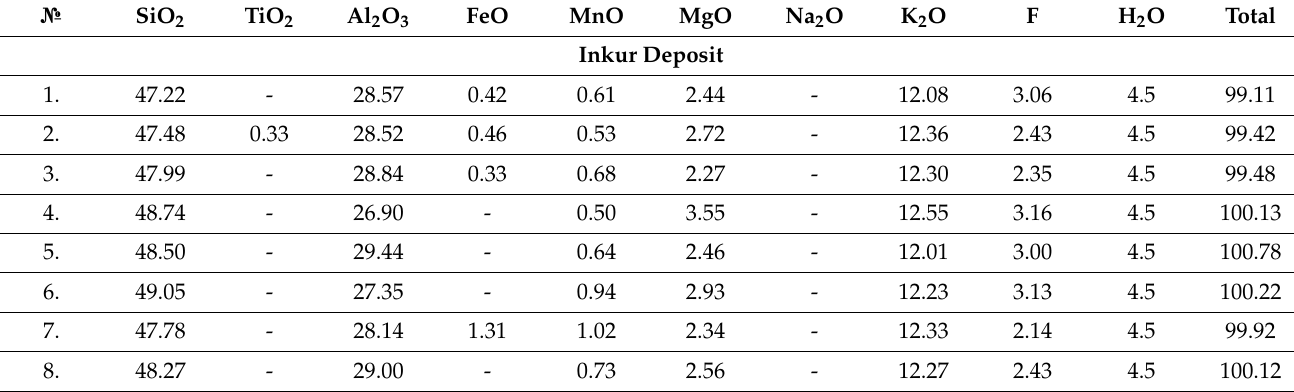
Table 2. Chemical composition of muscovite from Inkur and Kholtoson